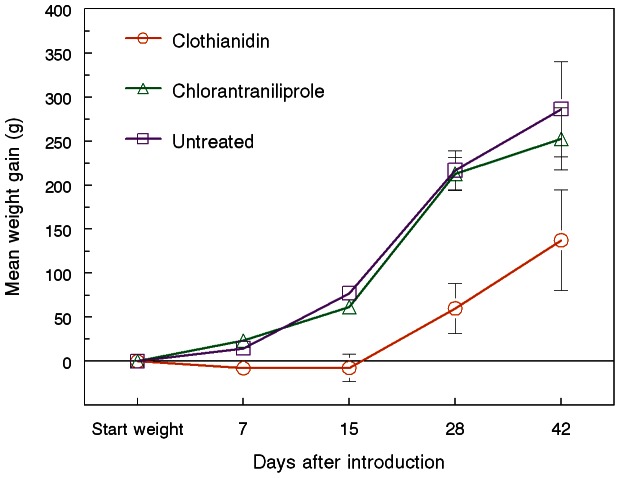
Colony weight change following exposure to treated turf.Mean (± SE) weight change (g) of Bombus impatiens colonies (10 per treatment) after foraging 6 days on insecticide-treated lawn turf with white clover and then being moved to an insecticide free site to openly forage for another 6 weeks (Repeated measures ANOVA: F
2,90 = 14.8, P<0.001; F
4,90 = 45.1, P<0.001; F
8,90 = 2.2, P<0.05 for treatment, date, and treatment×date interactions, respectively). Clothianidin-exposed colonies lagged behind the others on all dates (F
2,18 = 6.5, 15.6. 12.7, 3.1; P<0.01, 0.001, 0.001, 0.07 at 7, 15, 28, and 42 days after introduction, respectively.